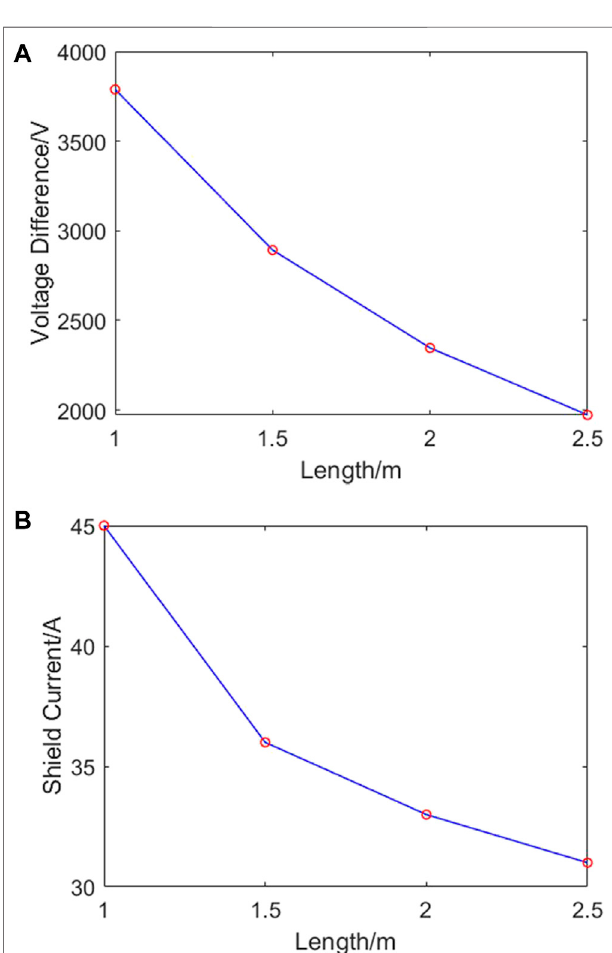
FIGURE 12 | Voltage and shield current of shield layer. (A) Voltage of shield layer. (B) Shield current of shield